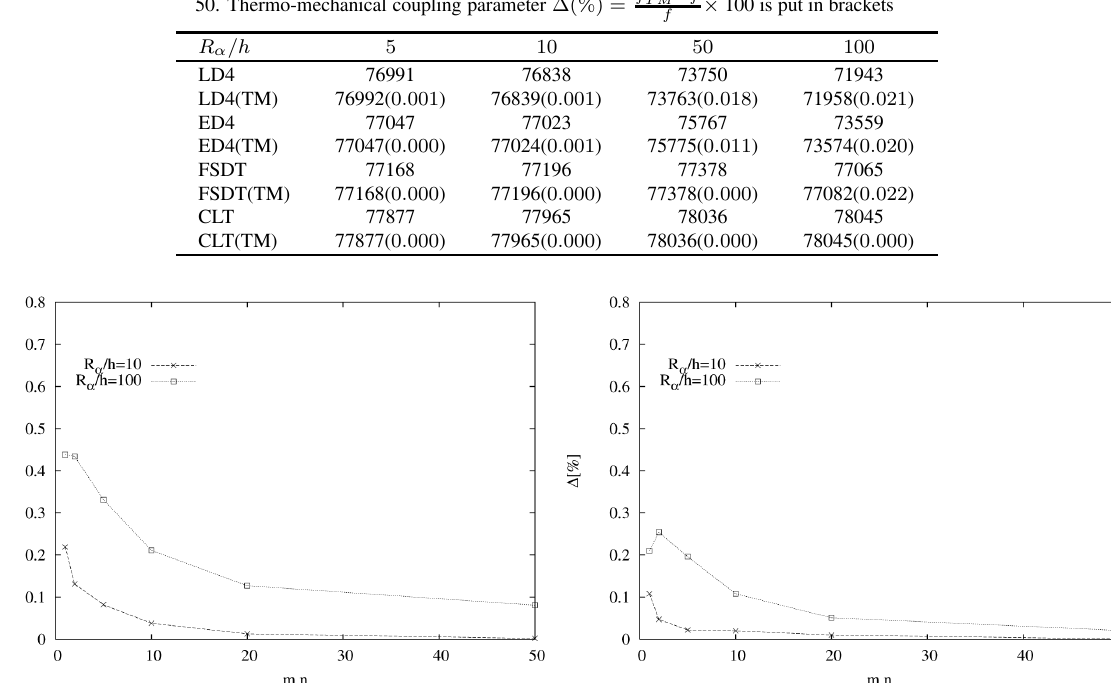
Fig. 3. Thermo-mechanical coupling in one-layered (on the left) and two-layered (on the right) isotropic shells for different values of wave number. Thermo-mechanical coupling parameter Δ(%) = f TM − f f × 100 calculated for the fundamental frequency by using LD4and LD4(TM)